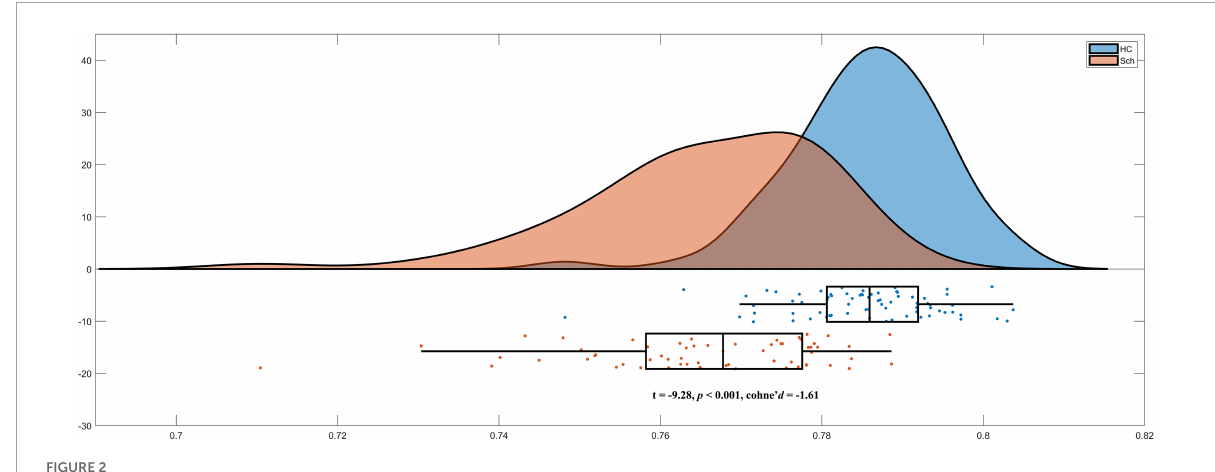
FIGURE2 Lower person-based similarity indexes (PBSIs) in schizophrenia compared with healthy controls (HCs).